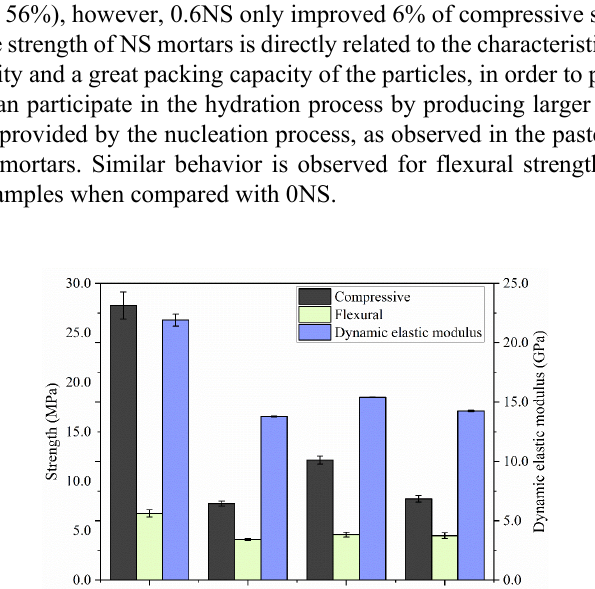
Erdem et al. [12] found at 28 days that the incorporation of 0.5% to 1.5% of NS in concretes with recycled aggregate increased the mechanical properties with the increase in the NS content. NS enabled an increase in the hydration rate of the cement paste (high Ca/Si ratio at the interface) and in the reactions of pozzolanic activity, constituting a strong connection between the cement mortar and the